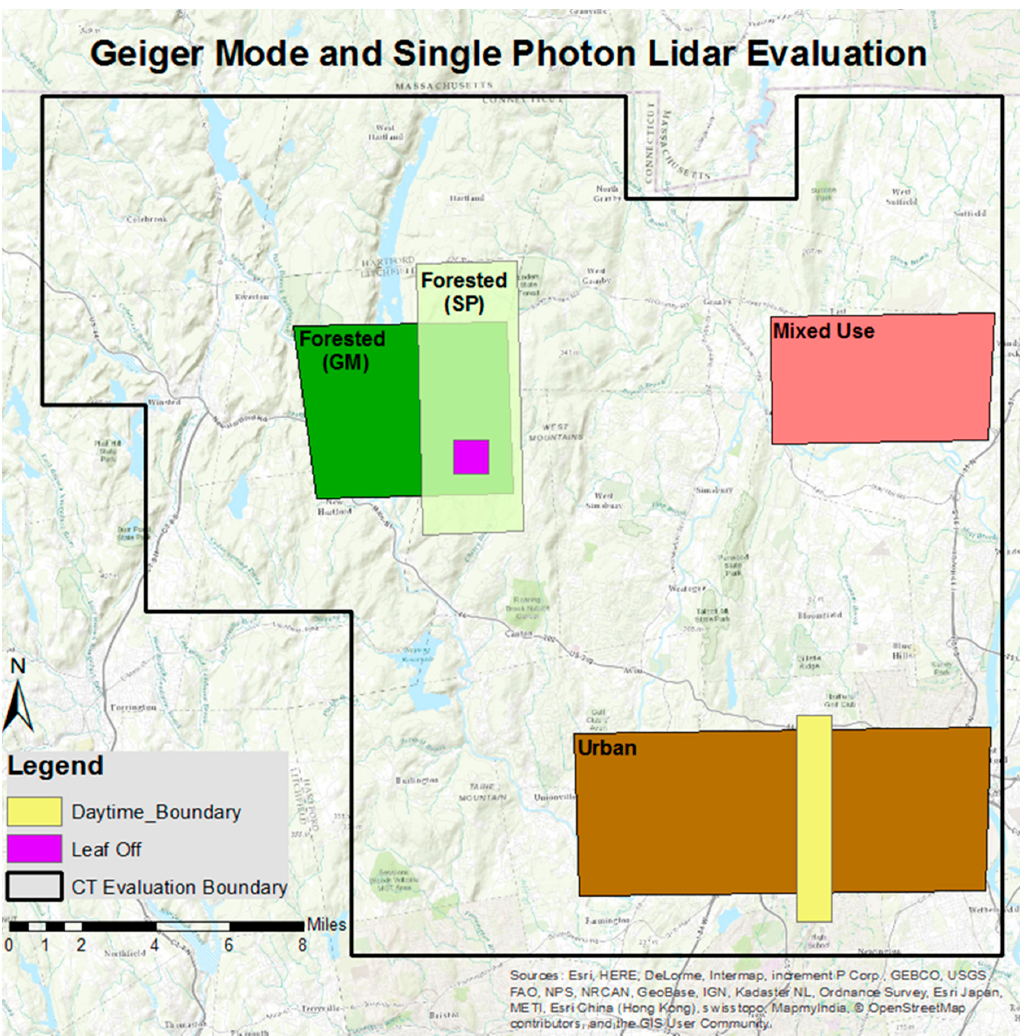
Figure 1. Areas of interest used for processing and assessing bare earth.